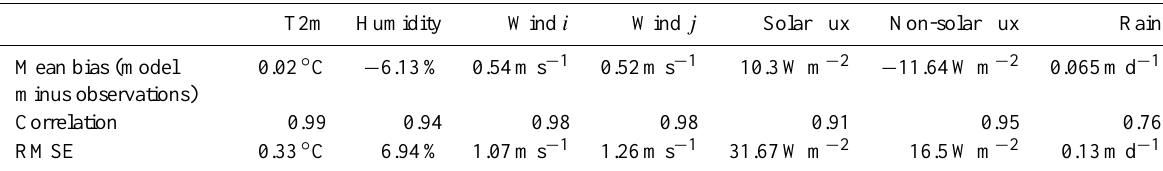
Table 2. Comparisons of ECMWF atmospheric values and measurements at the PAPA station.